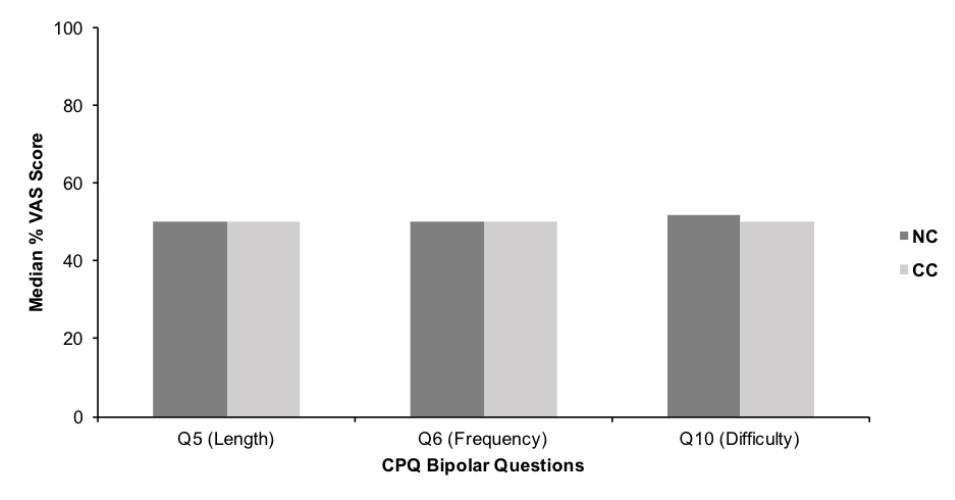
FFigigururee 33 CPQ Bipolar Questions: Median VAS Scores.